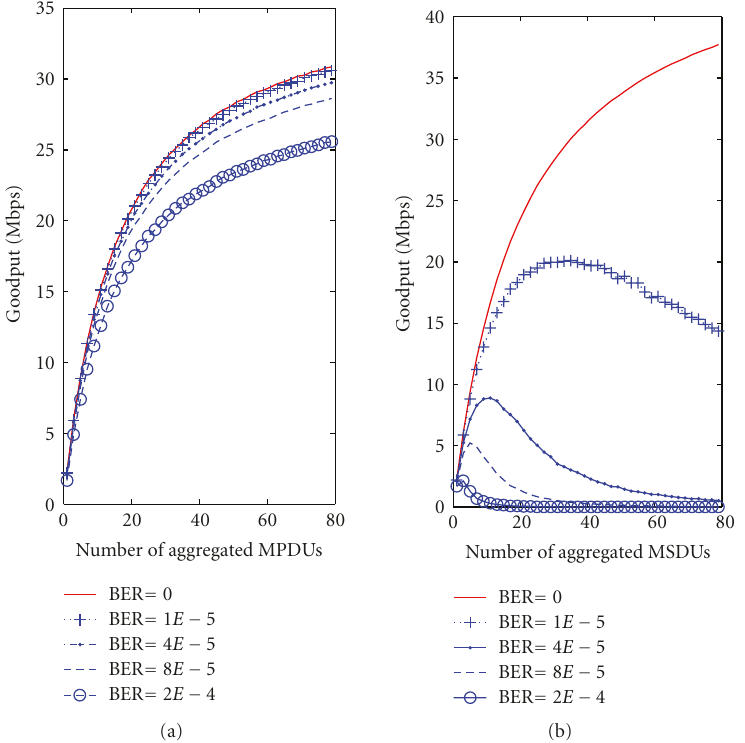
Figure 2: Goodput performance versus the number of aggregated MPDUs (a) and the number of aggregated MSDUs (b).